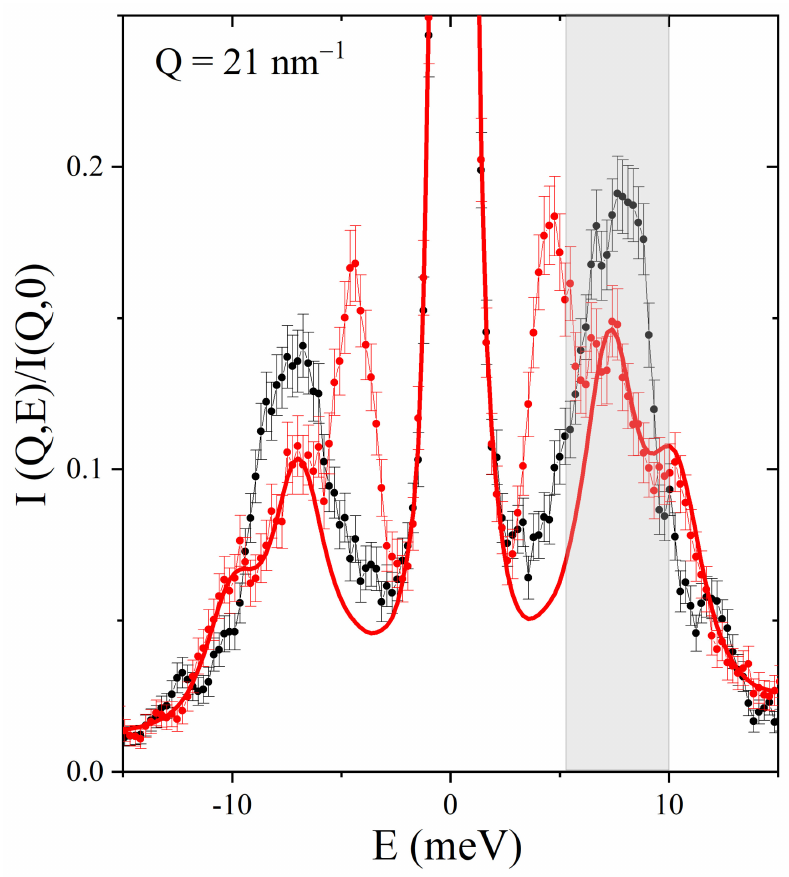
Figure 7. IXS spectra measured on polycrystalline ice (black dots) and AuNP frozen suspension (red dots) at Q = 21 nm − 1 are compared in a restricted energy range after normalization to the respective maxima. The shadowed gray band covers the zone where the optical modes of ice are detected. The plot includes as a red line the best-fitting lineshape of the frozen suspension spectrum without its low-frequency DHO component after similar